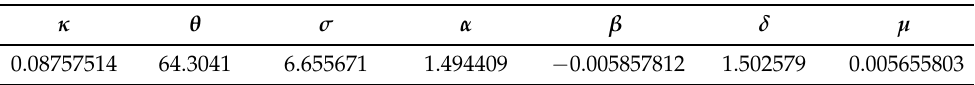
Table 7. Estimation Result of OU and LDOU model on energy-switching data.